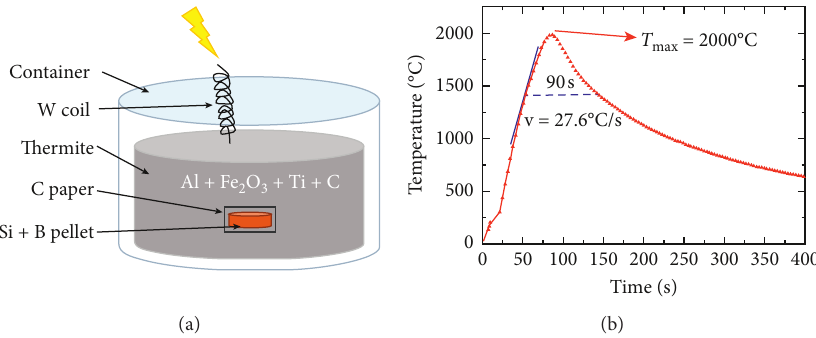
Figure 1: (a) Inner structure of chemical oven and its (b) temperature combustion curve with time. Table 1: Molar ratio of Si :B for different samples. Sample no.